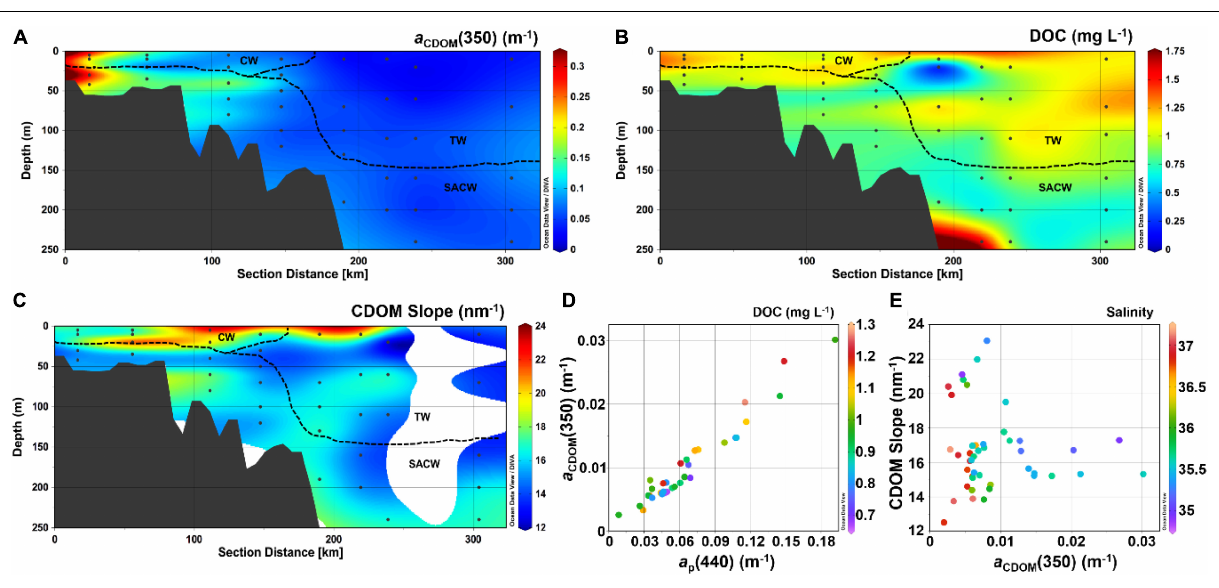
FIGURE 5 | Vertical distribution (0–200 m) of (A) a CDOM (350) (m – 1 ), (B) DOC (mg L – 1 ) and (C) CDOM spectral slope ( S , nm – 1 ). (D) Scatter plots of a CDOM (440) vs. a CDOM (350) with DOC color-coded, and (E) a CDOM (350) vs. S with salinity color-coded. Produced with Ocean Data View (Schlitzer,